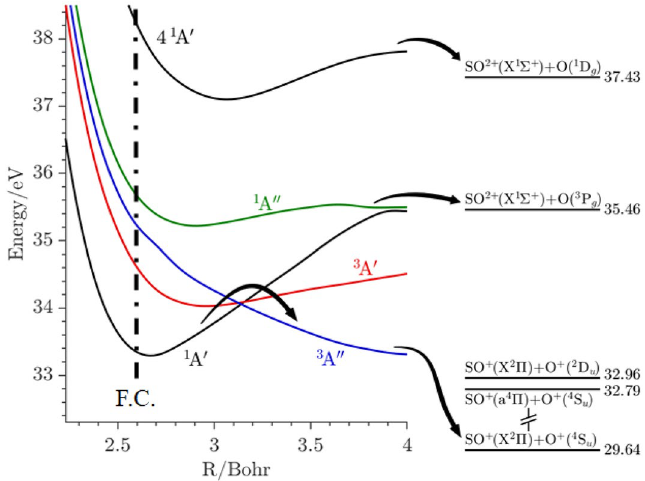
Figure 2. Minimal energy paths (MEPs) along the SO distance (R) for the 1 A ′ , 1 A ″ , 3 A ′ and 3 A ″ PESs. These MEPs are deduced from the SO 22+ PESs (Figs. S3–S6) by looking for the minimal energy for each SO distance along the different OSO angles. We show also the 4 1 A ′ potential for R SO = 2.7 Bohr and Θ = 120°. The asymptotes are located using the data from Table S3. The dashed dotted vertical line corresponds to the middle of the Franck–Condon (F.C.) region for the SO 2 (X 1 A 1 ) → SO 2 2+ + 2e - transition. The arrows illustrate the fragmentations discussed in the